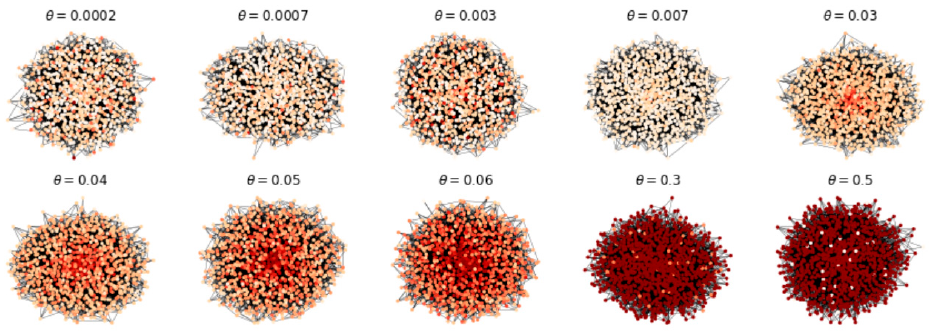
Figure 4. Impact of policy dissemination rate θ on the number of recipients of CLPP.